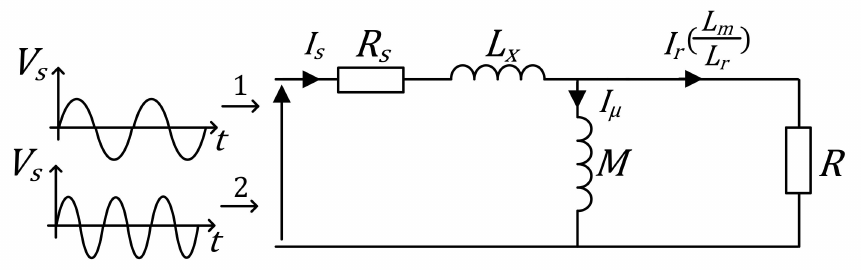
Figure 1. The inverse “ Γ ” equivalent circuit with the sinusoidal voltage test signals of different